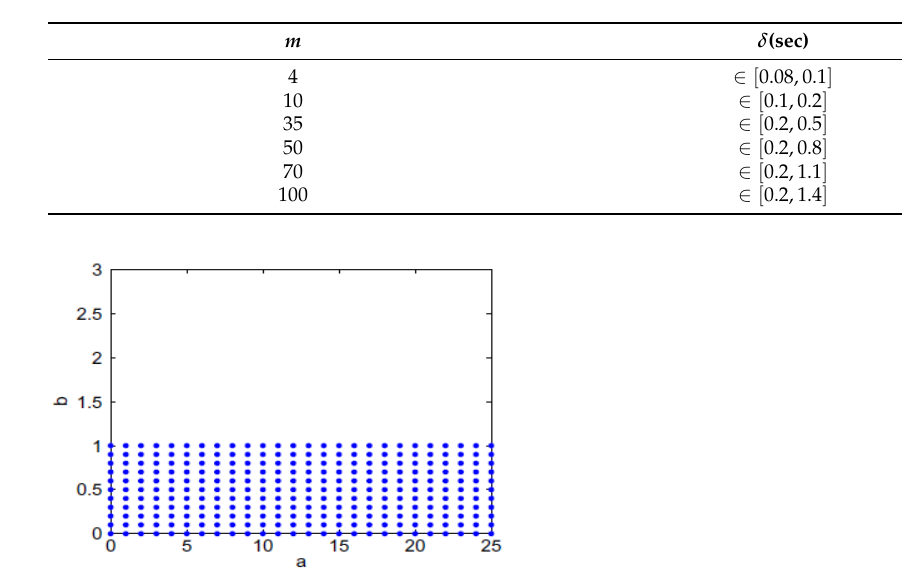
Table 1. Variation results of m and δ .